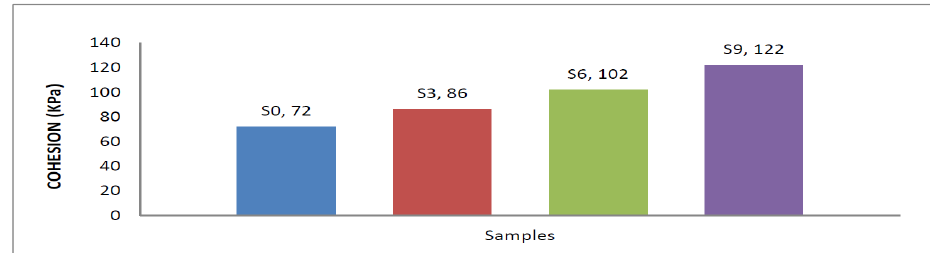
Figure 23. Effects of lime and cement dust on cohesion strength of swelling soil.